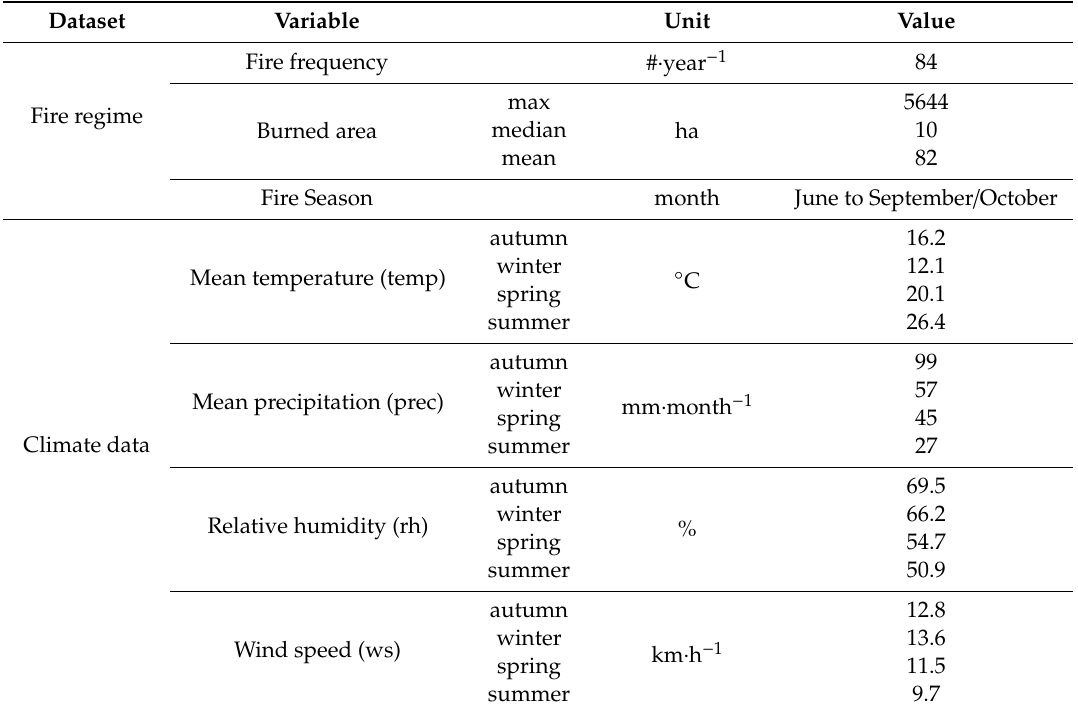
Table 1. Main characteristics of the current Corsican fire regime and climate normal over the 1979–2016 period. Fires ( > 5 ha) were extracted from the Prom é th é e database [51], and climate data were extracted from ERA-Interim Climate Models